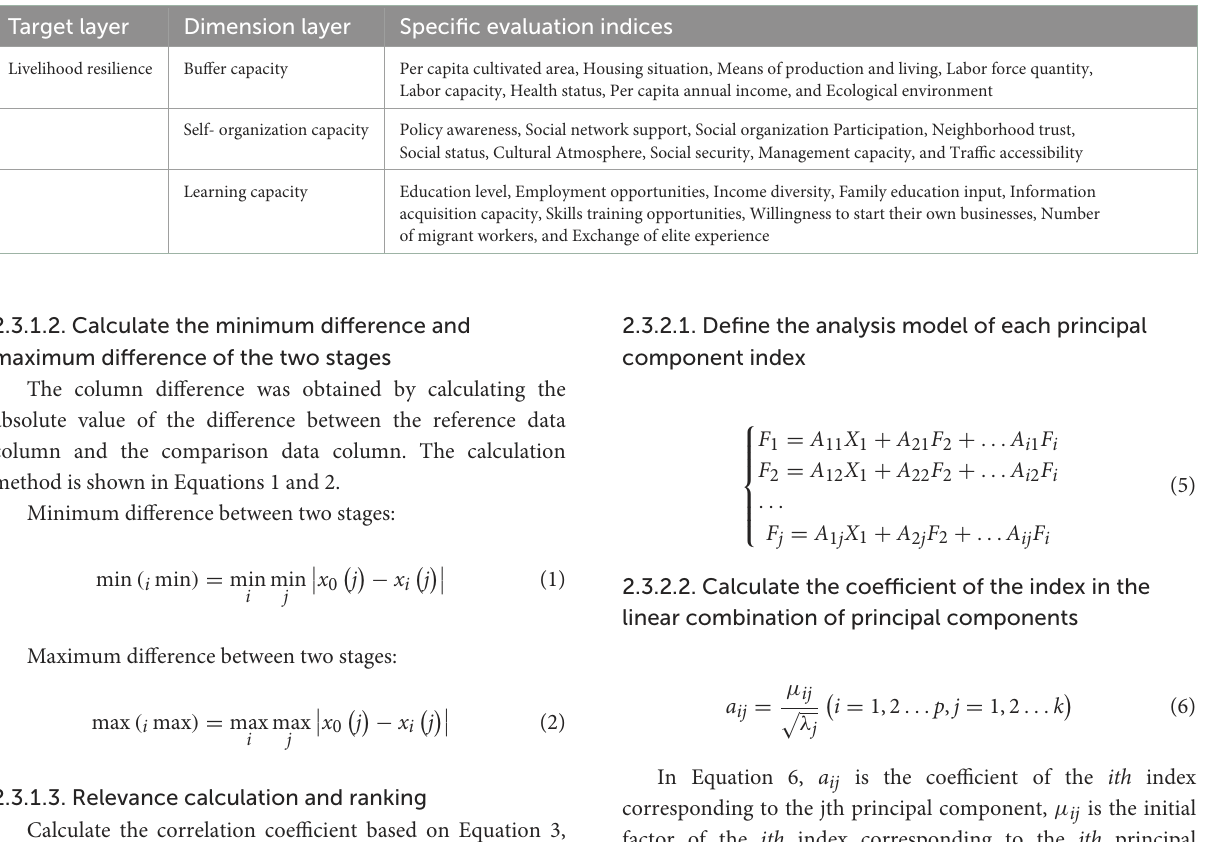
TABLE 1 Alternative indices for livelihood resilience evaluation of resettled